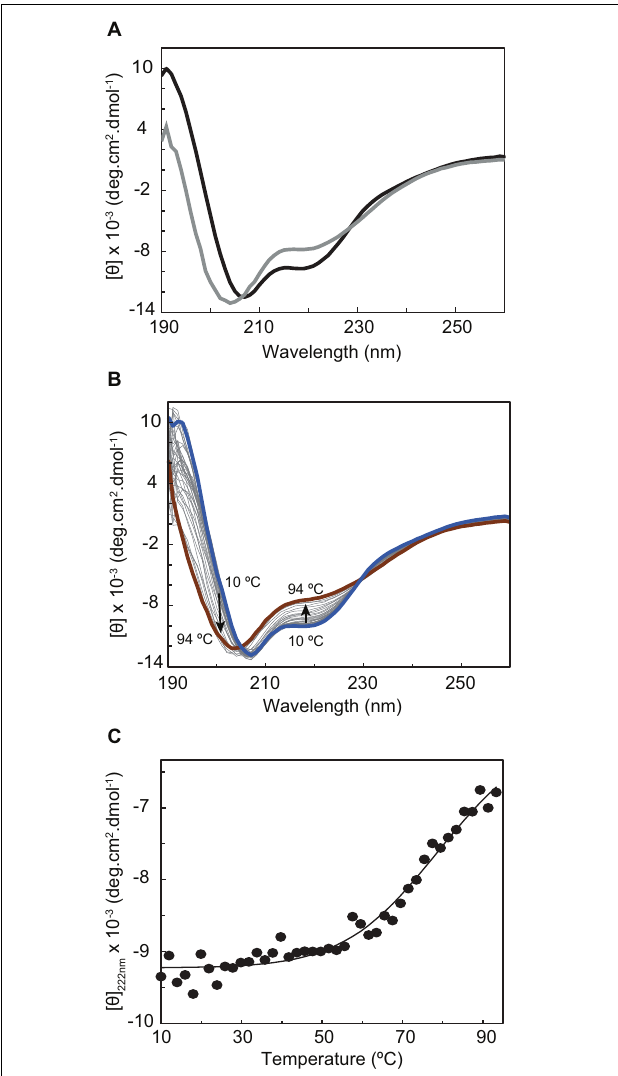
FIGURE 3 | Circular dichroism studies of cytochrome CbcL. (A) Far-UV CD spectra of CbcL (10 µ M in 10 mM sodium phosphate pH 8) as purified (black) and after the temperature ramp (gray) at 25 ◦ C. (B) Far-UV CD spectra of CbcL at different temperatures (10–94 ◦ C). (C) Thermal unfolding of CbcL. Mean residue ellipticity [ θ ] variation at 222 nm as a function of temperature. The solid line represents the fitting of the experimental data to a two-state transition, resulting in a melting temperature of 81 ± 5 ◦